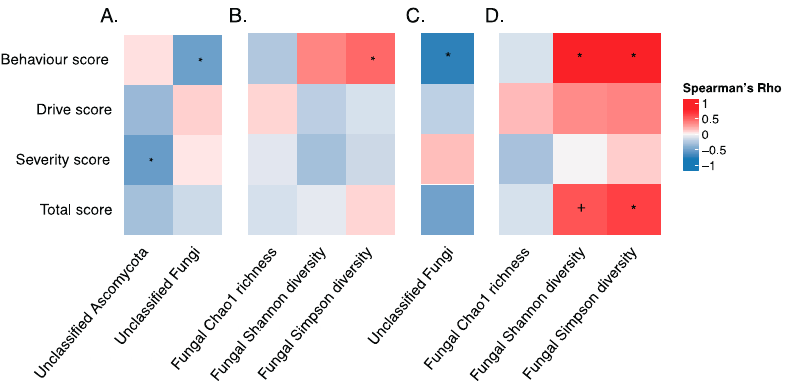
Figure 4. Correlation between hyperphagia and microbiota. ( A ) Correlation of hyperphagia score with fungal genus level in the whole dataset. ( B ) Correlation of hyperphagia scores with fungal species-level diversity in the whole dataset. ( C ) Correlation of hyperphagia score with fungal genus-level abundance within the PWS group. ( D ) Correlation of hyperphagia scores with fungal species-level diversity within the PWS group. The q -values were generated using the Bonferroni method: + indicates q -values between 0.05 and 0.1; * indicates q -values less than 0.05.